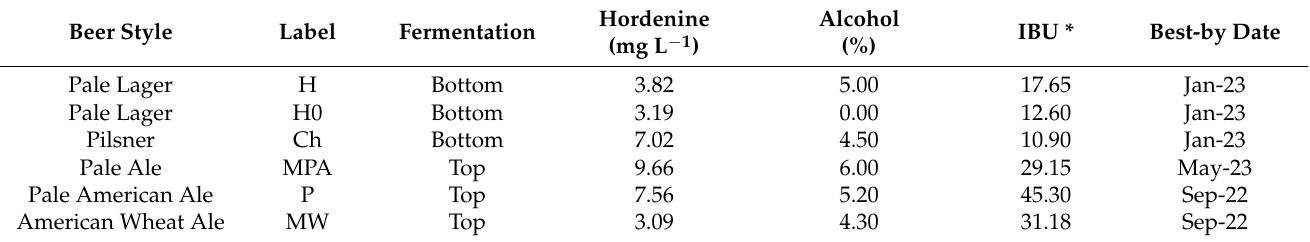
Table 1. Beer samples used for the study, including the information used for their